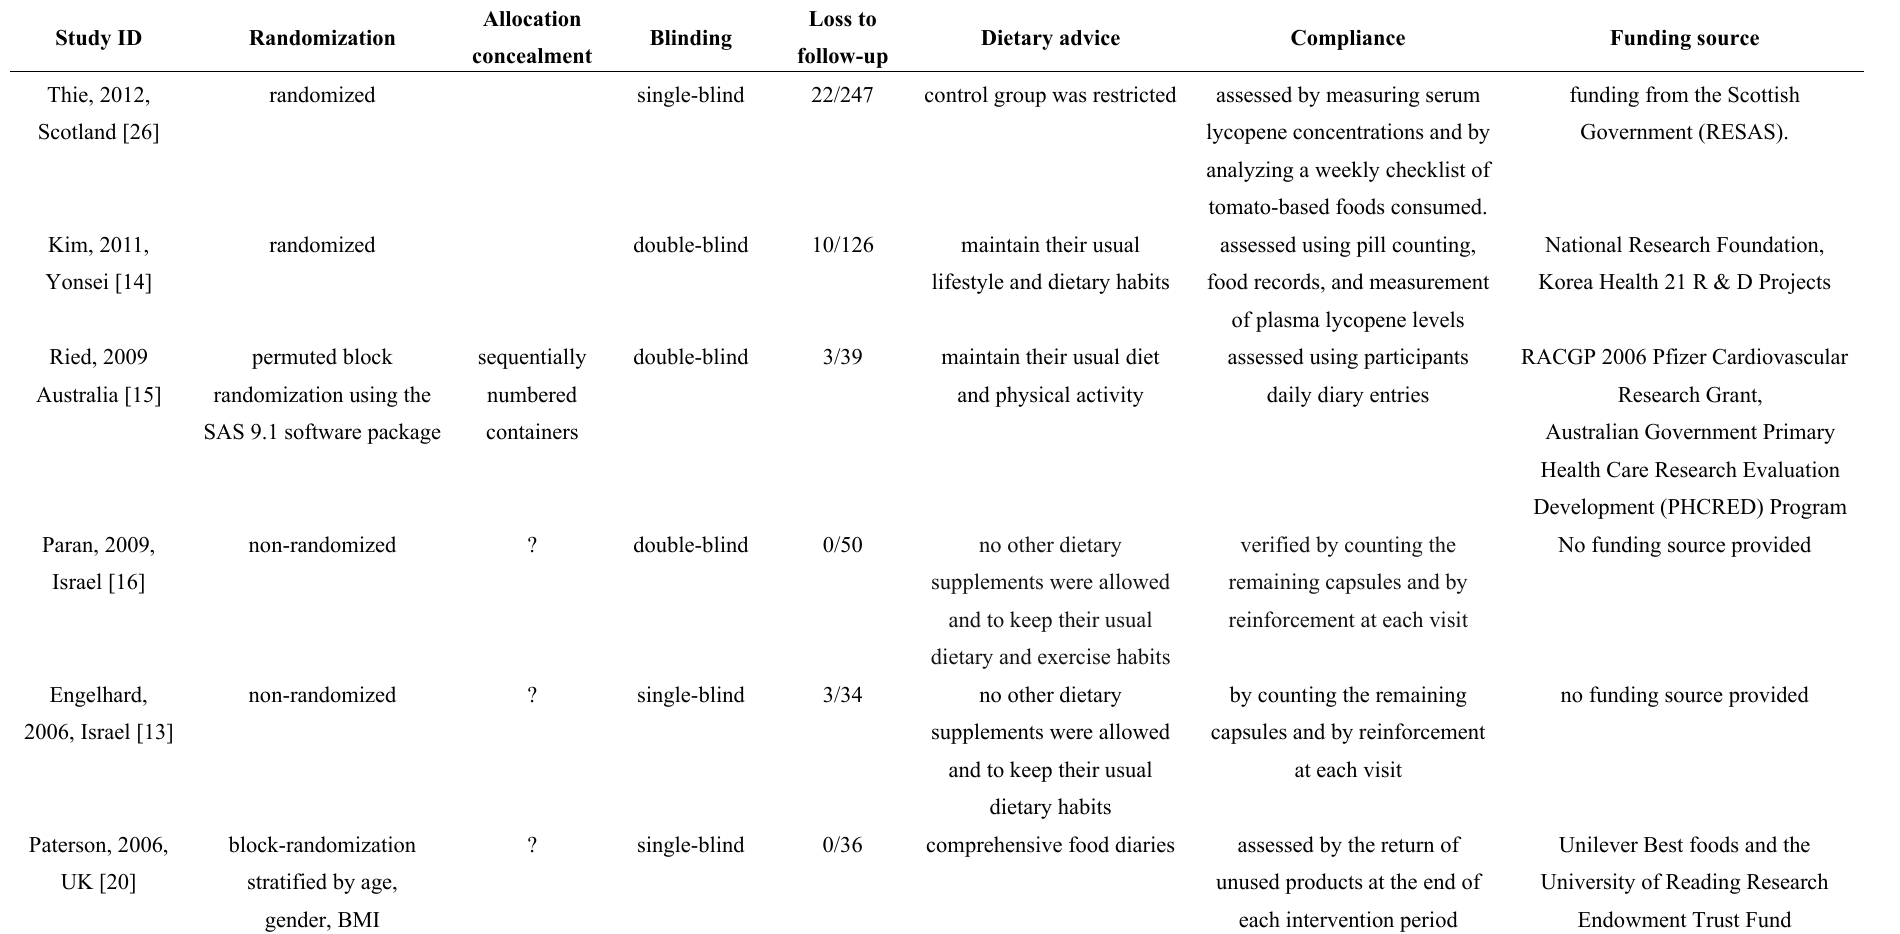
Table 2. Quality assessment of included